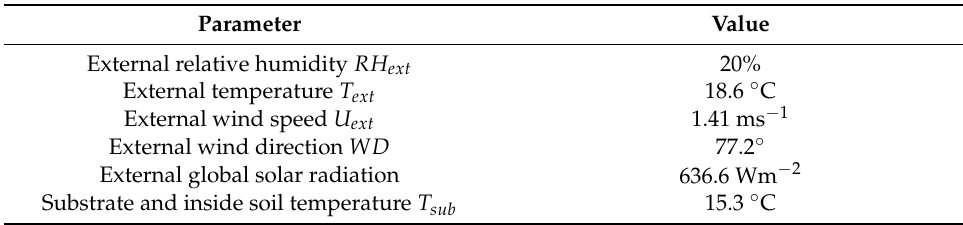
Table A2. Experimental conditions.